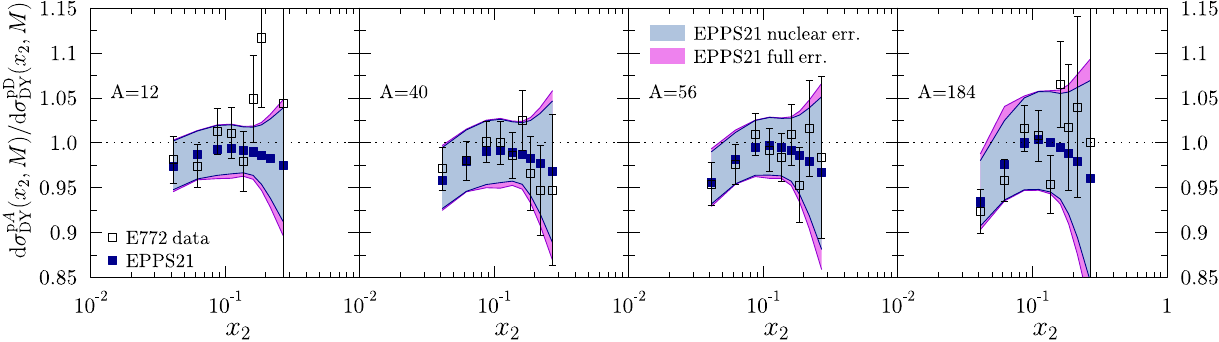
Fig. 25 Drell–Yan cross-section ratios of the E772 collaboration [56] compared with the EPPS21 analysis. The solid blue points show our central results, inner blue bands the nuclear uncertainties, and the purple bands the total uncertainty